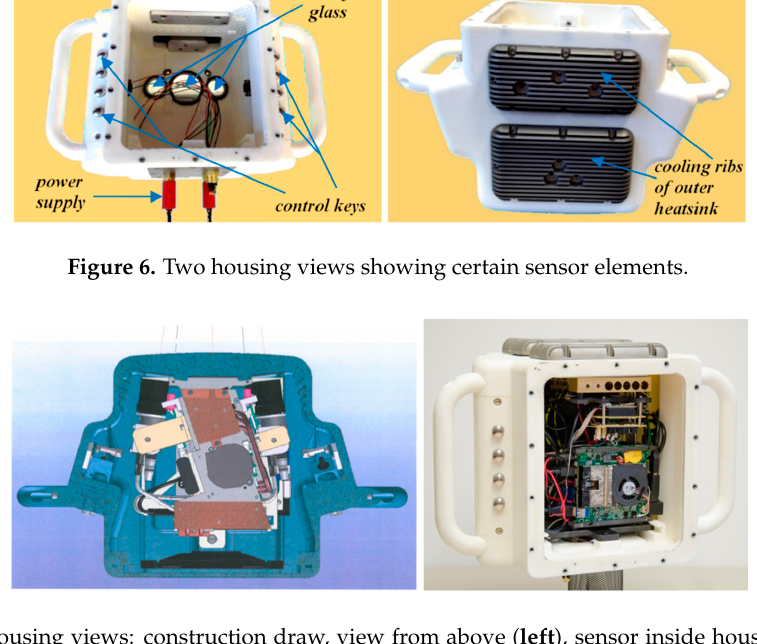
Figure 9. Selected images from fringe sequence: parts of Gray-code sequence ( a , c ) and sinusoidal fringes ( b , d ) taken from underwater measurements of a frustum of a pyramid. In all cases at least seven measurements were performed. Noise determination was performed additionally. It was defined as standard deviation of the measured 3D points from a small locally fitted plane (or sphere, respectively). The obtained maximum error results are documented by Table 2. Note that for E L and E F the percentage values are given in contrast to Equations (6) and (7), and noise is an averaged value over all noise measurements. Table 2. Calibration evaluation results (given in %) using specimen ball bar ( E Lb ), frustum of pyramid ( E Lp ), and plane ( E F ), and averaged 3D noise values.